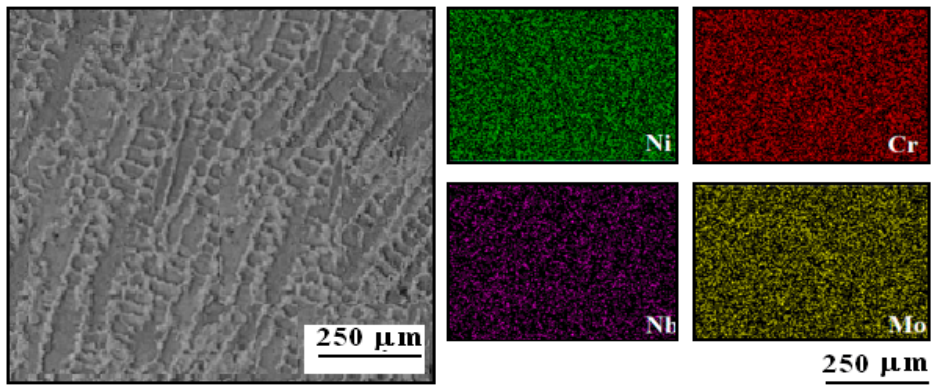
Figure 6. Quality EDS analysis of nickel, chromium, niobium, and molybdenum map distribution of WIn coating.